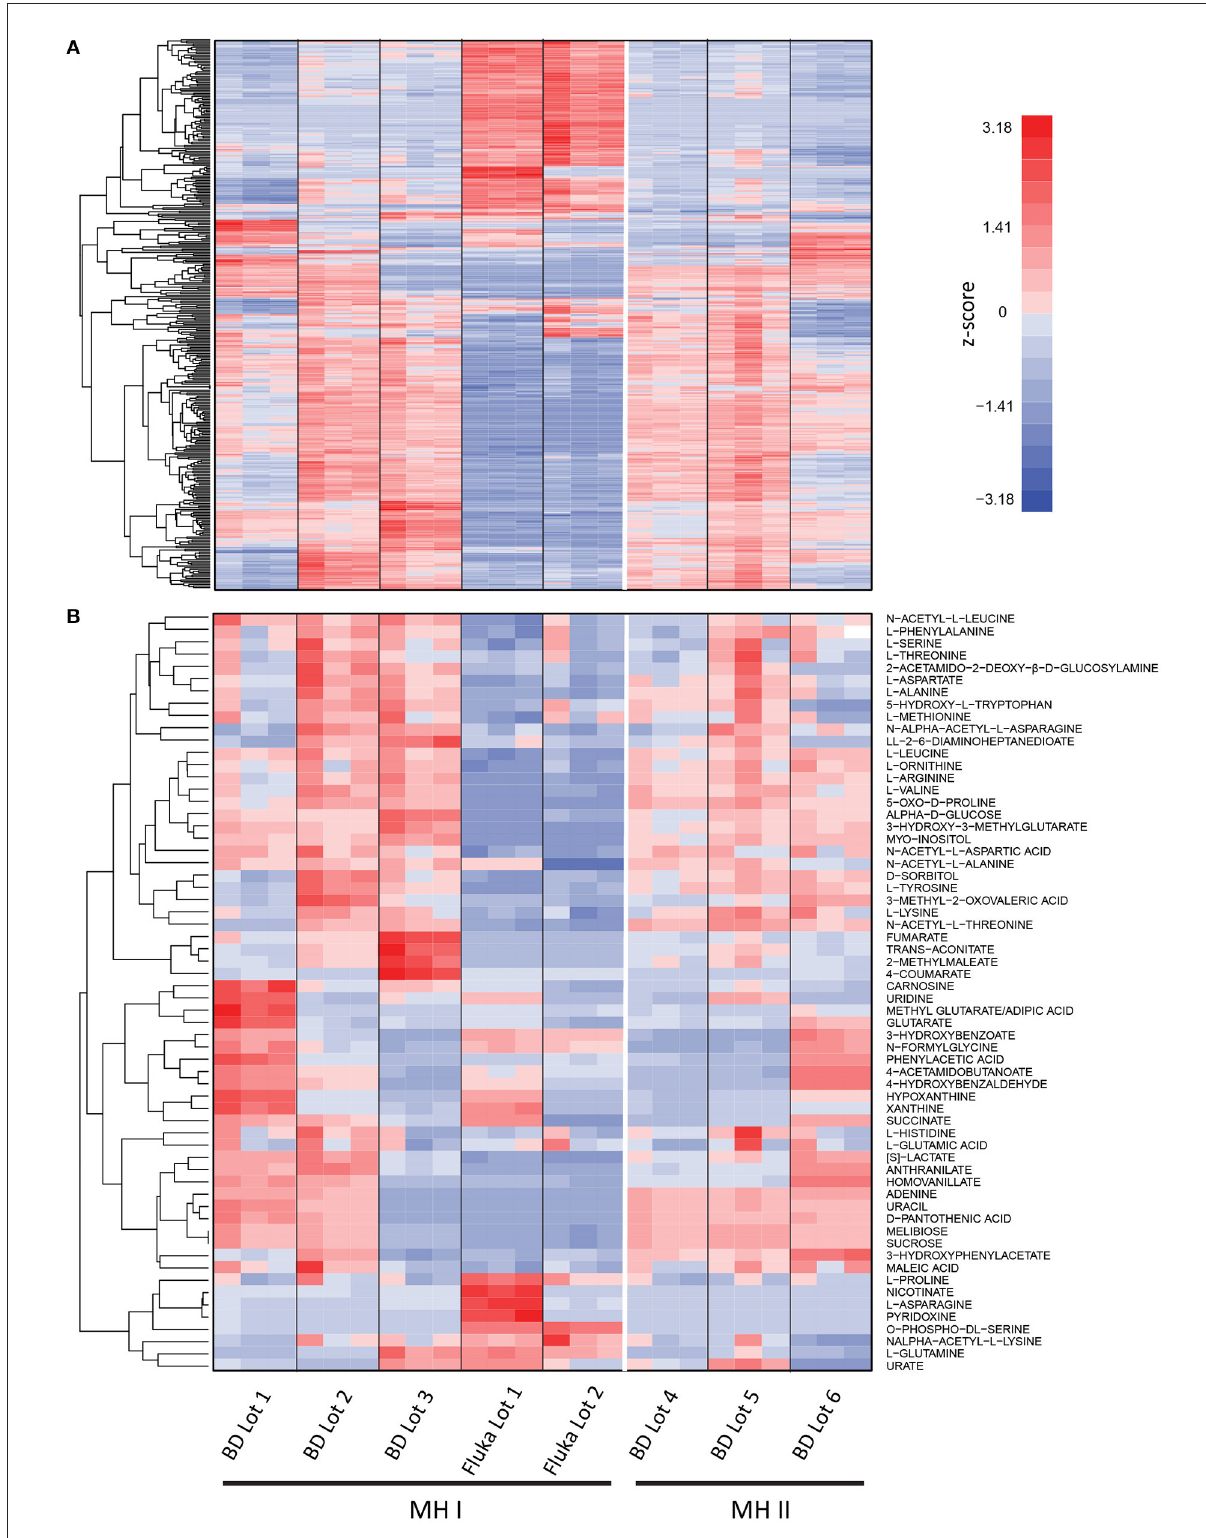
FIGURE1 Mass spectrometry analysis of different lots and suppliers of Mueller Hinton (MH I) and cation adjusted Mueller Hinton (MH II) medium. (A) Untargeted analysis identified significant differences ( p < 1 × 10 − 5 ) in 359 features were observed in at least one lot of medium ( n = 3). (B) Targeted UHPLC-MS analysis identified variability in concentrations of many common microbial nutrients, including various amino acids, nucleotides, and sugars. Signal intensities are shown as z-scores (i.e., mean centered, variance stabilized signal intensities). See Source Data File